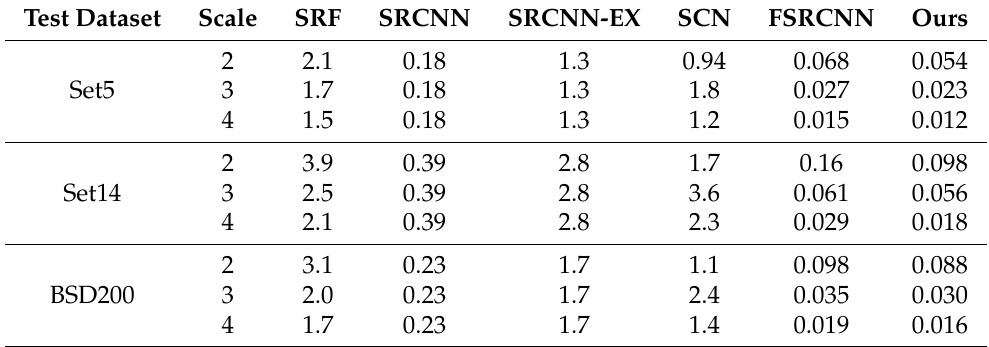
Table 3. The results of the testing time (in second) on three test datasets. All models are trained on the 91-image